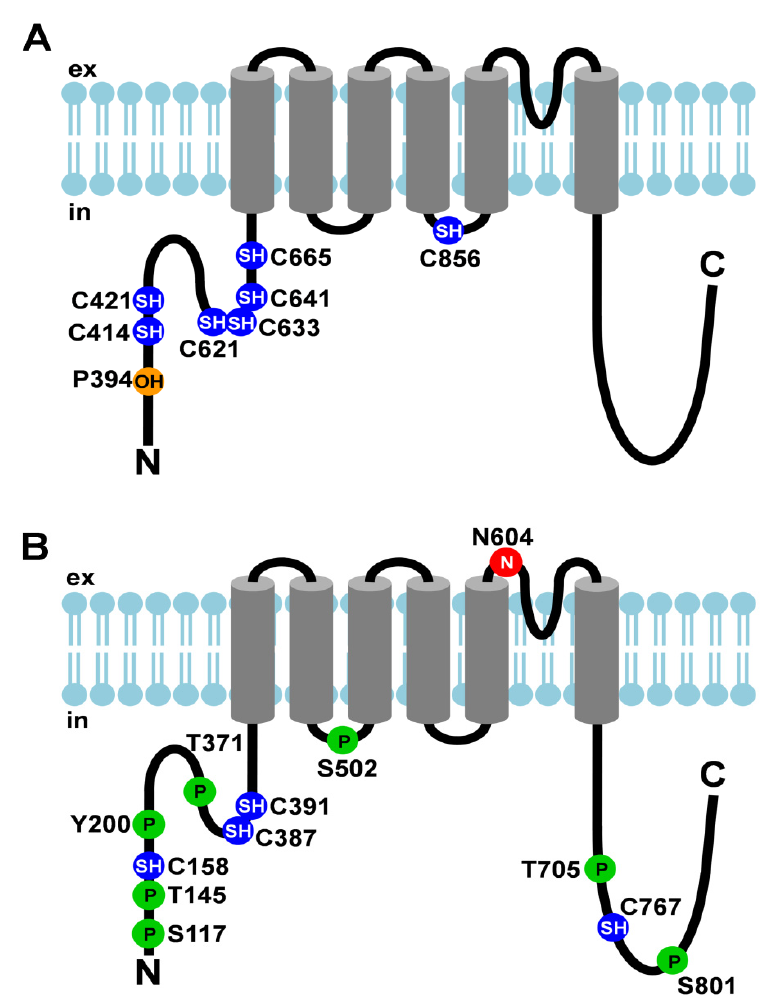
Figure 1. Post-translational modifications of TRPA1 and TRPV1. ( A ) Cartoon depicting TRPA1 and its post-translational modifications; ( B ) Cartoon depicting TRPV1 and its post-translational modifications. Amino acid residues that undergo post- translational modifications are depicted as circles. The N-linked glycosylation site is shown as a red circle with an N, cysteines that are modified are shown as blue circles with SH, hydroxylated proline is depicted as an orange circle with OH, and phosphorylation sites are represented by green circles with P. ex, extracellular; in,